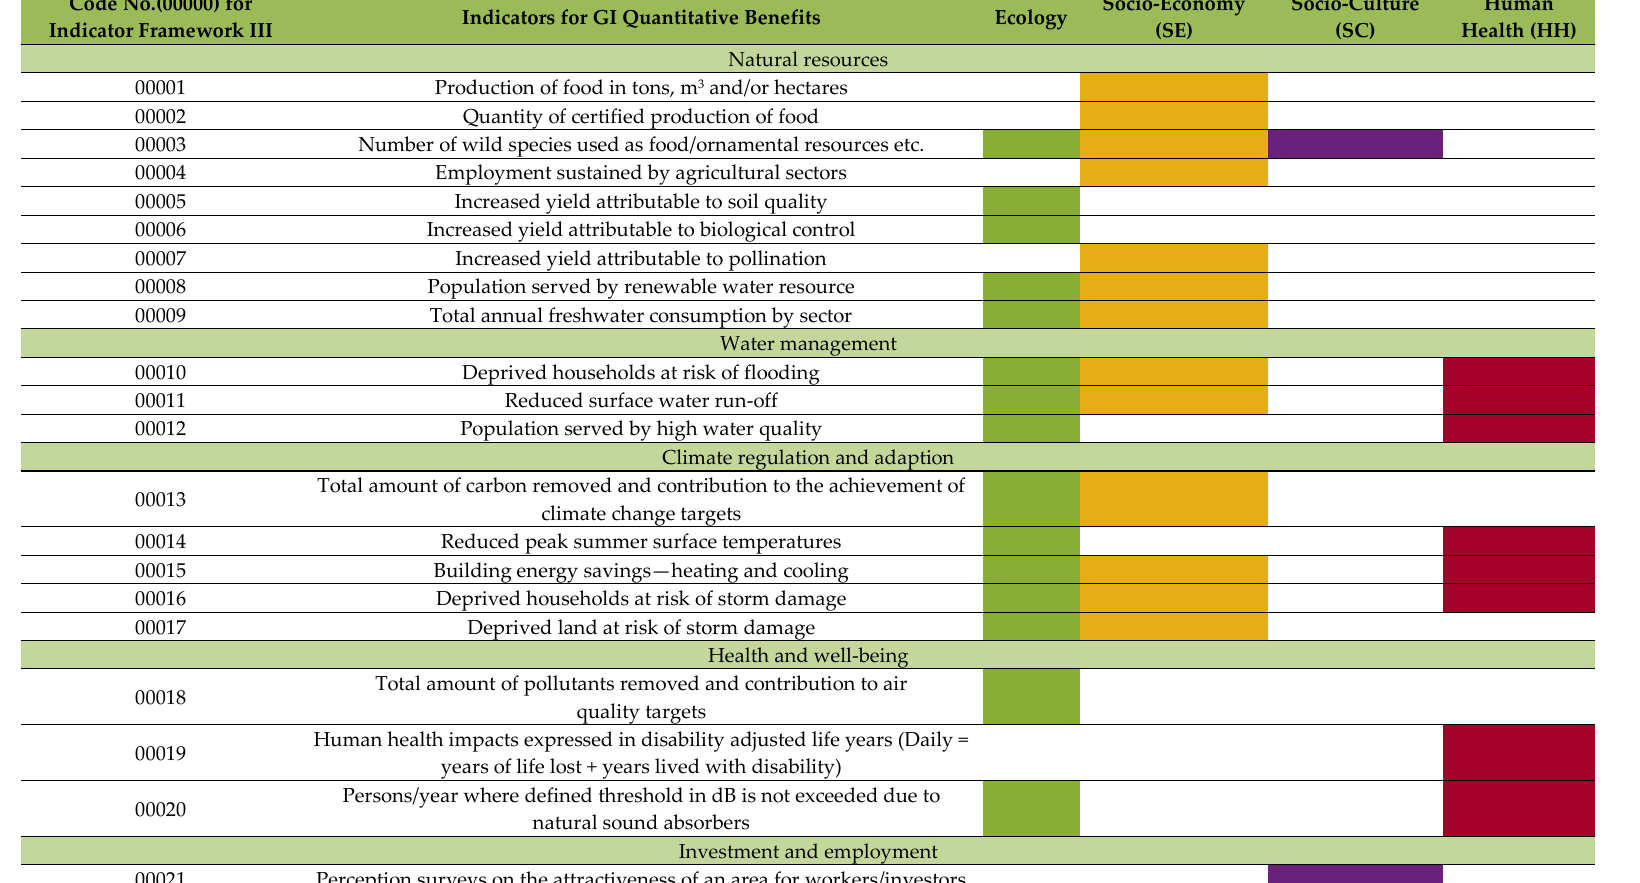
Table A3. Indicator framework III for a shift towards green economy from EMDA classified in terms of four dimensions, i.e., ecological dimension (green color), socio-economic dimension (yellow color), socio-cultural dimension (purple color), and human health (red color) dimension. Code No.(00000)